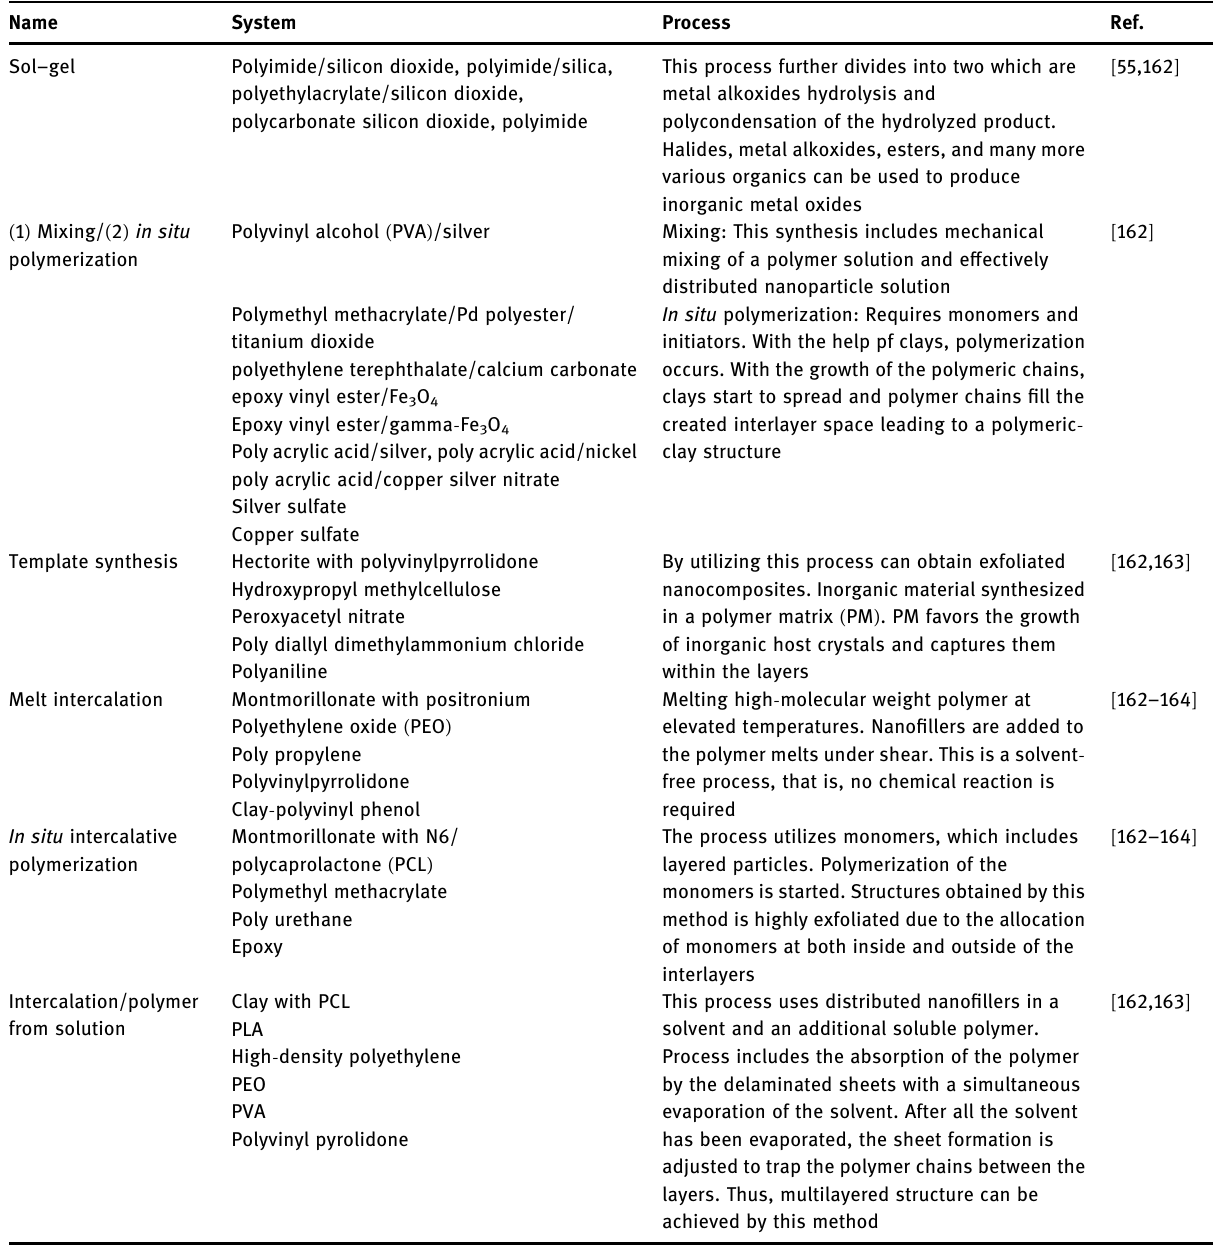
Table 16: The processing techniques of PMNCs